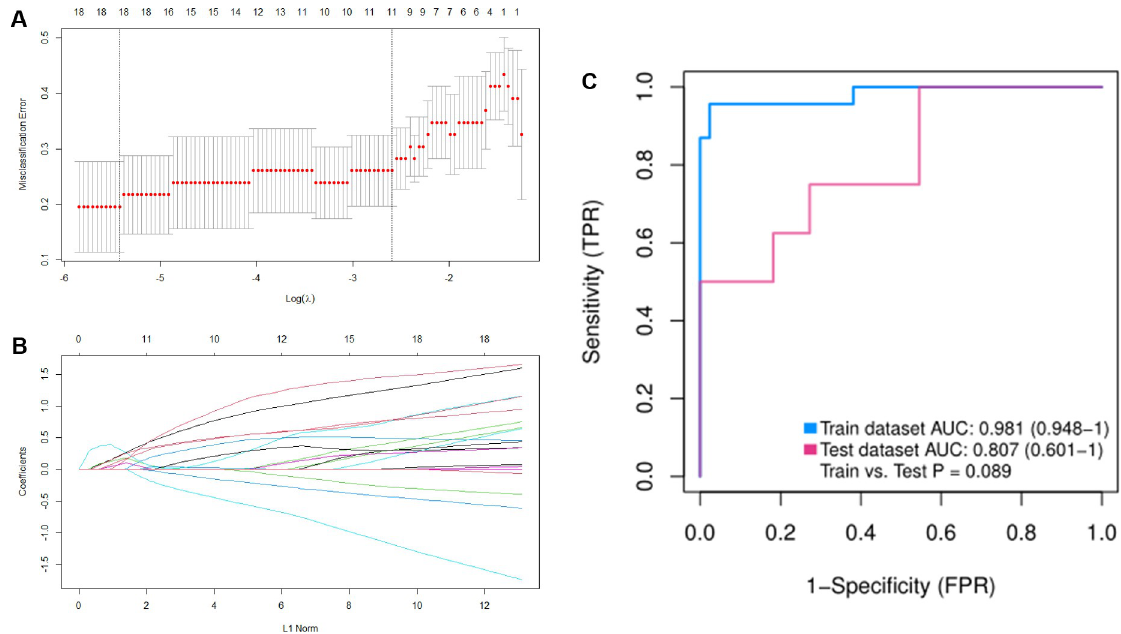
Fig 7. The potential key genes of tendinopathy were screened by LASSO regression model. In Fig 7A and 7B, the ordinate is the value of the coefficient, the lower abscissa is log( λ ), and the upper abscissa is the number of non-zero coefficients in the model at this time. (A) Selection of the best parameter (number of non-zero coefficients in the model at this timet (B) LASSO coefficient spectrum of 18 differentially expressed genes selected by optimal (s timeti (C) Comparison of ROC curves between training set and validation set for gene signature.